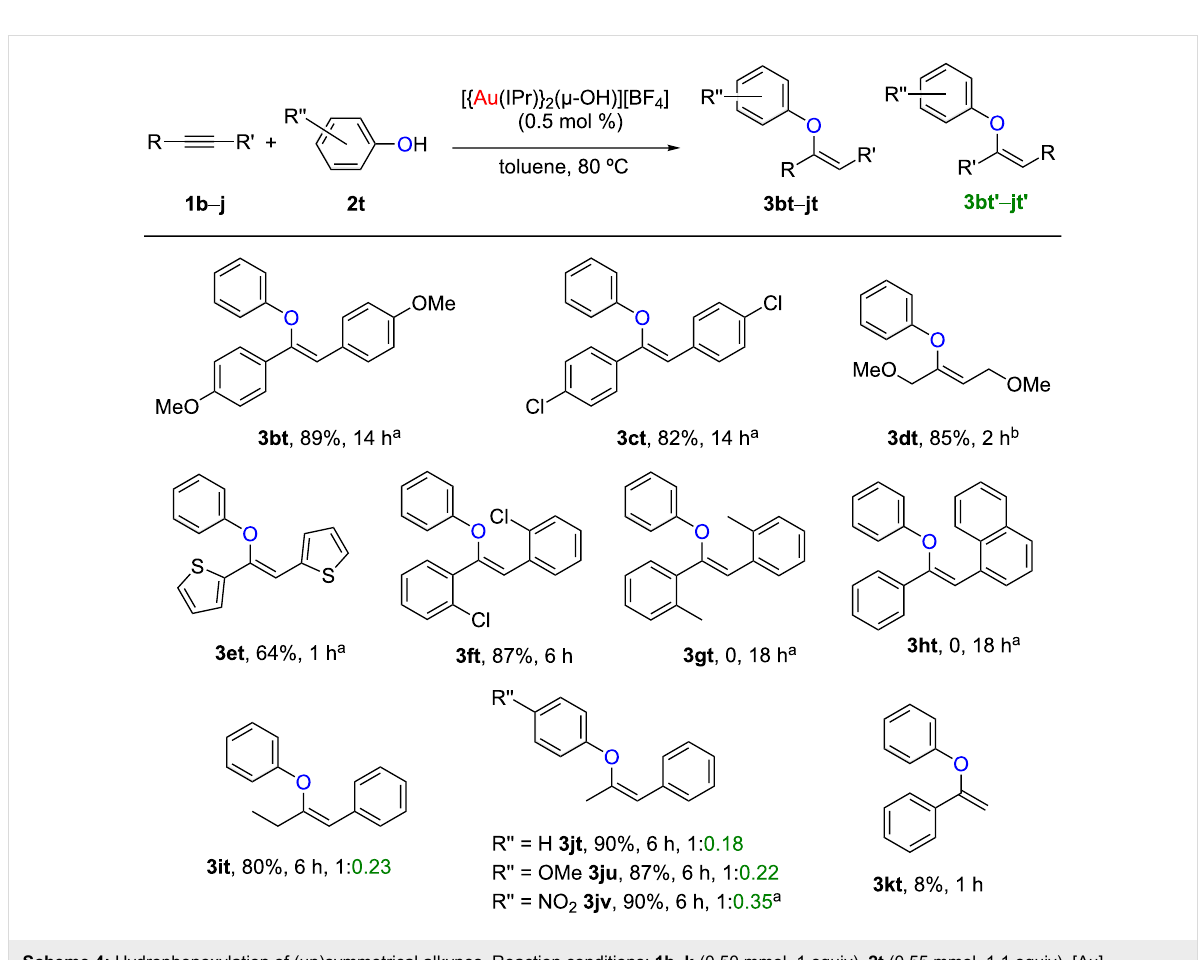
Scheme 4: Hydrophenoxylation of (un)symmetrical alkynes. Reaction conditions: 1b – k (0.50 mmol, 1 equiv), 2t (0.55 mmol, 1.1 equiv), [Au] (2.5 µmol, 0.5 mol %), toluene (1 mL), 80 °C. Isolated yields, average of two runs. Ratio determined by 1 H NMR. a [Au] (5 µmol, 1 mol %), 110